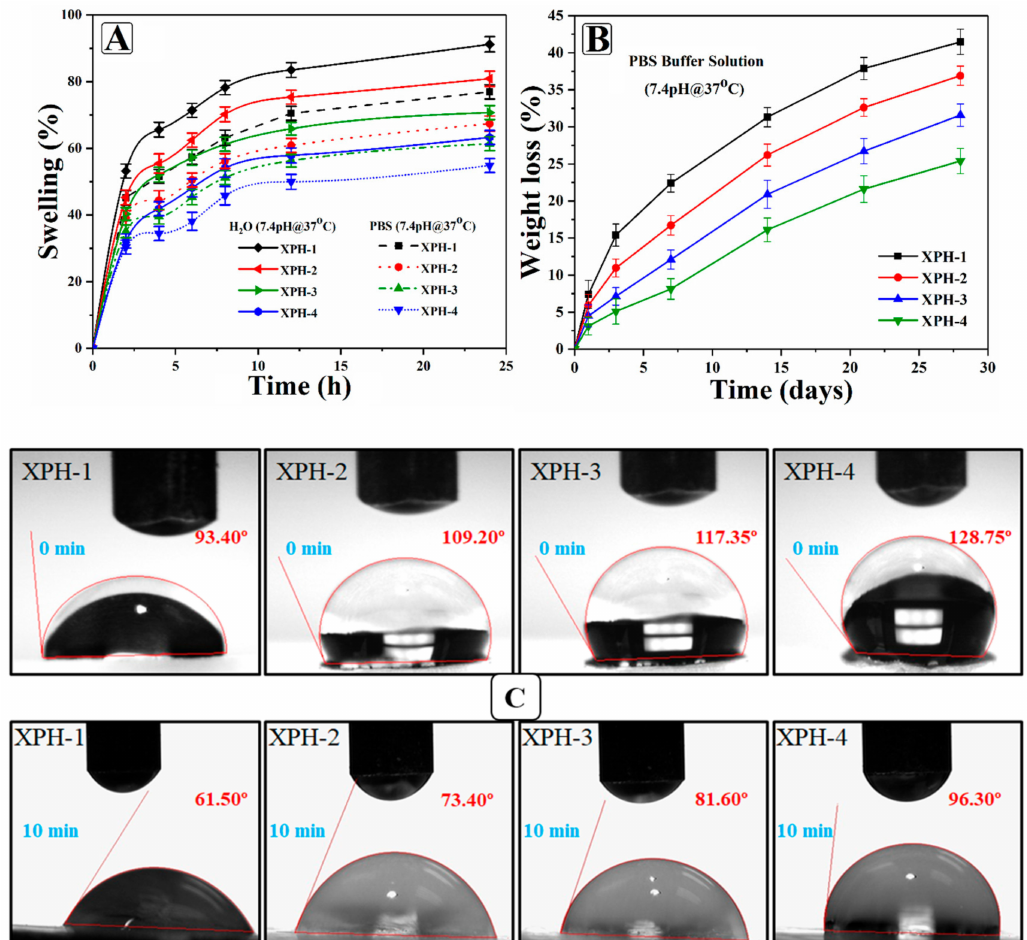
Figure 5. ( A ) Swelling analysis of the hybrid nanocomposite scaffolds in different media (pH 7.4) at 37 ◦ C, ( B ) degradation of hybrid nanocomposite scaffolds samples in PBS solution (pH 7.4) at 37 ◦ C, and ( C ) wetting analysis of scaffold samples to determine hydrophilicity and hydrophobicity at room